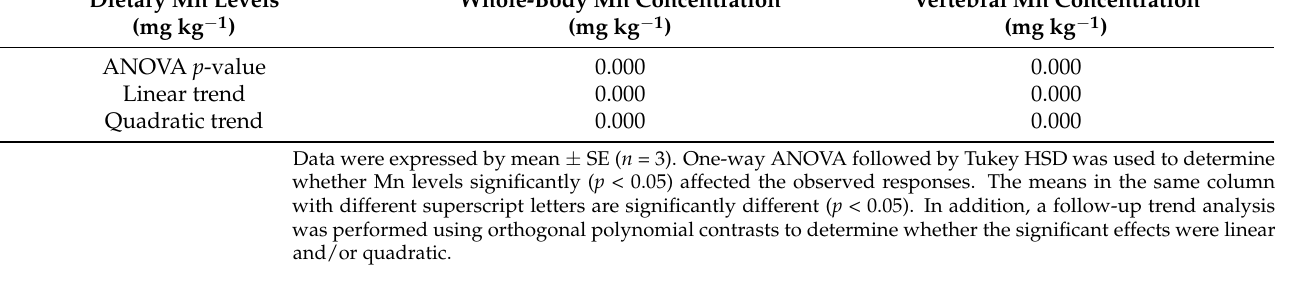
Figure 2. Effect of dietary Mn on the activities of antioxidant enzymes and ROS levels in the liver of post-larval coho salmon. ( A ) Mn-SOD activity; ( B ) CAT activity; ( C ) GSH-PX activity; ( D ) MDA